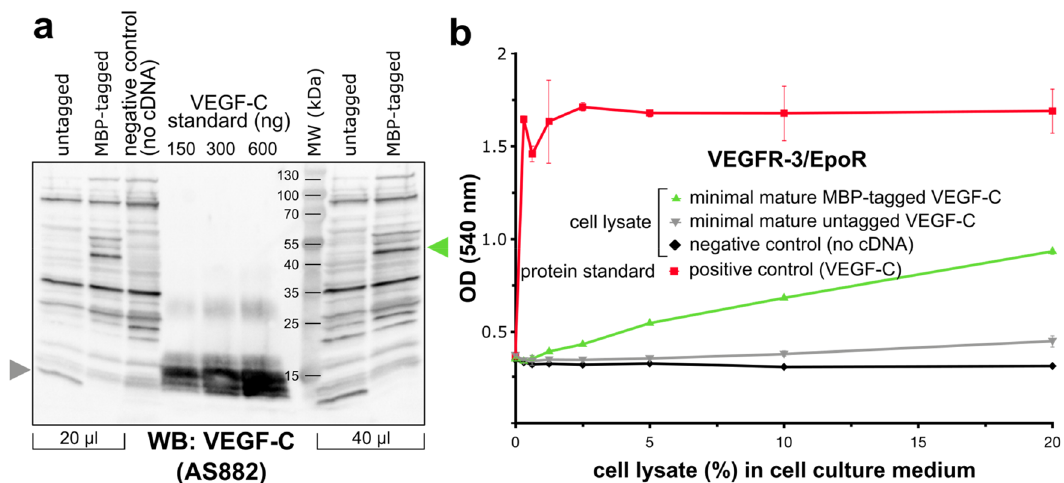
Figure 5. VEGF-C expression with the fusion tag MBP increases significantly the bioactivity of VEGF-C produced in the cytoplasm of E. coli Origami (DE3). ( a ) Western blot comparing MBP-tagged and untagged VEGF-C. The MBP-tagged and untagged VEGF-C bands are indicated by green and gray arrows, respectively. ( b ) The untagged VEGF-C exhibits only very low levels of bioactivity in Ba/F3-VEGFR-3/EpoR assay. (n = 2) Error bars indicate ±